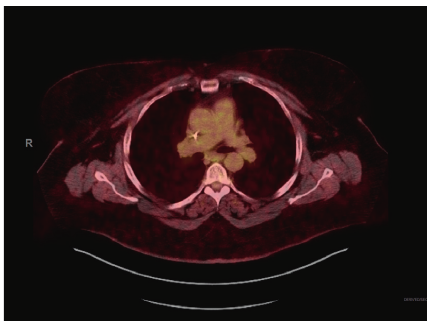
Figure 4: 5/2017 interval near resolution of the bilateral hilar and subcarinal lymphadenopathy.